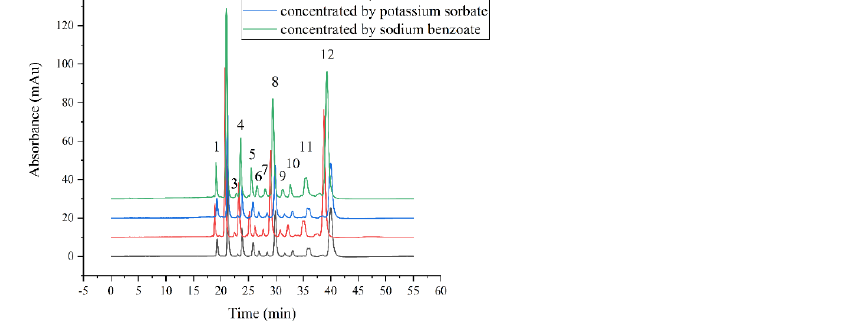
Figure 5. Liquid chromatogram profiles of original and concentrated blueberry juice. 1: delphinidin − 3 − O − galactoside; 2: delphinidin − 3 − O − glucoside; 3: delphinidin − 3 − O − arabinoside; 4: cyanidin − 3 − O − galactoside; 5: petunidin − 3 − O − galactoside; 6: petunidin − 3 − O − glucoside; 7: petunidin − 3 − O − arabinoside; 8: malvidin − 3 − O − galactoside; 9: peonidin − 3 − O − glucoside; 10: malvidin − 3 − O − glucoside; 11: malvidin − 3 − O − arabinoside; 12: delphinidin − 3 − O − xyloside.